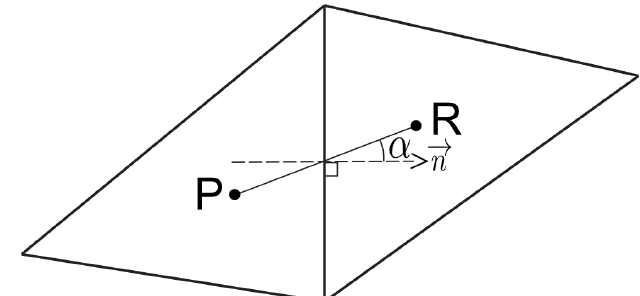
Fig. 4. Non-orthogonality of finite volumes.